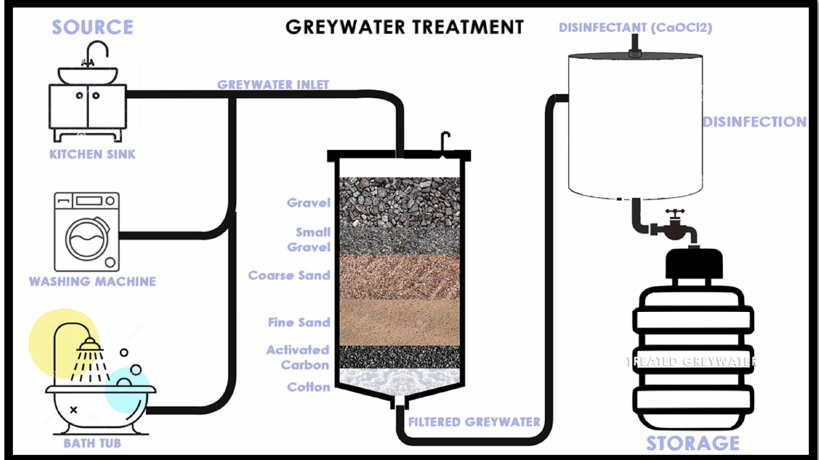
Figure 1. A schematic diagram of the proposed greywater treatment procedure.